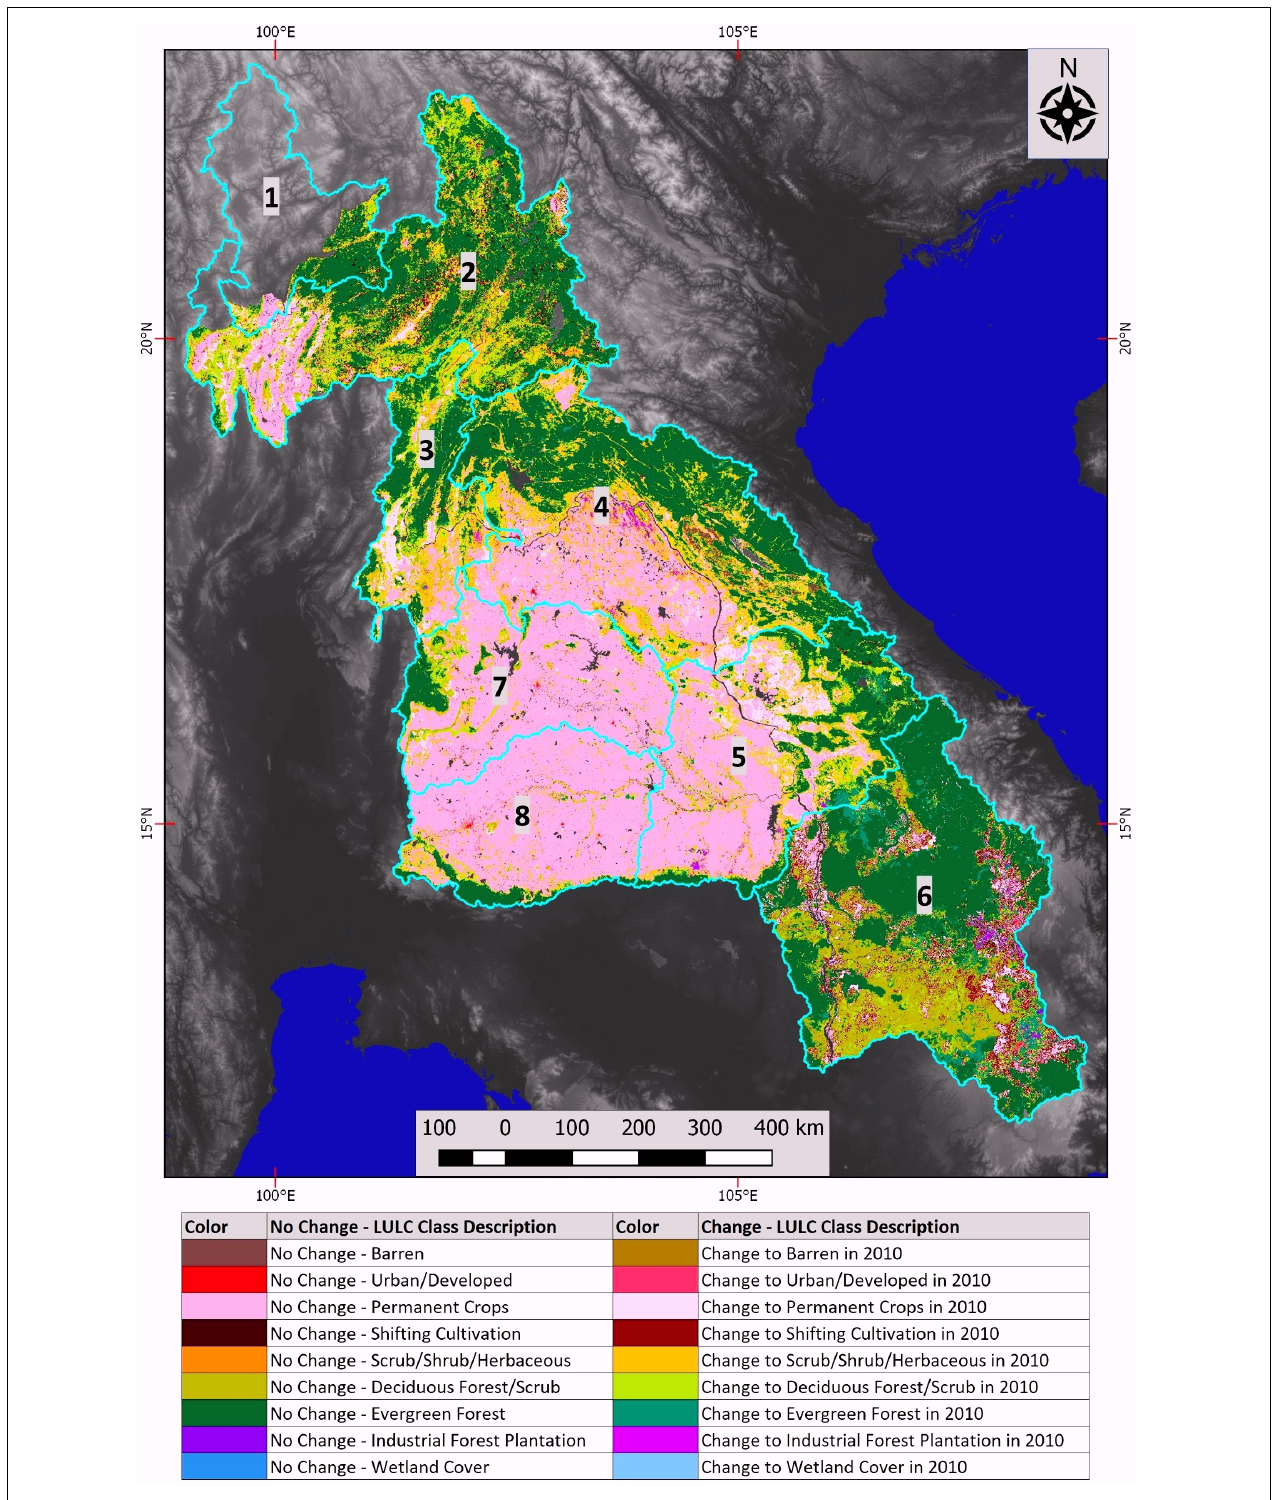
FIGURE 4 | 1997–2010 LULC change map for study area with SB boundaries overlain in cyan for SBs 1–8. All LULC change classes are colorized to show the LULC class for the end date of 2010, as well as whether the class was of a “change” or “no-change” type, given the change map consists of both change and “no change” classes. For a given LULC category, the “change” class color was assigned a lighter color than the “no change” class (e.g., barren no change was set to dark brown, while change to barren was set to light brown). The SB #s are included as black text. The backdrop image adjacent to the LULC map is a 90 m DEM from SRTM